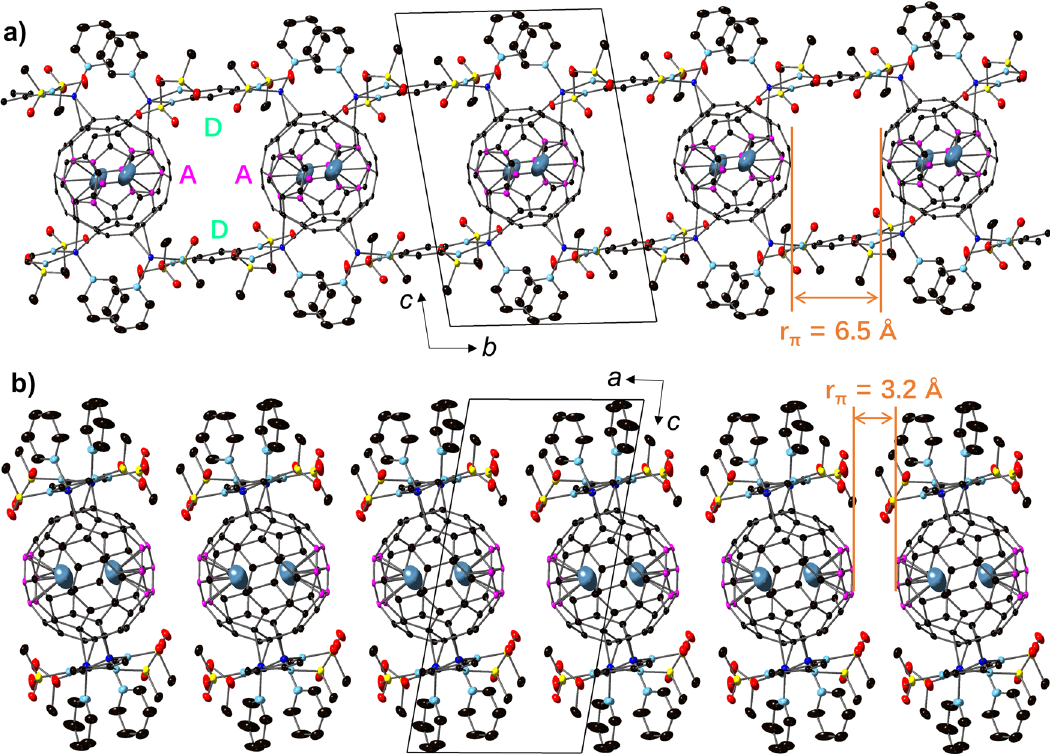
Fig. 2 The structure arrangements of the ladder-like chains. a 1D ladder-like structure along the b -axis in the bc plane (anion NTf 2 − and hexane molecules are omitted). One Li + @C 60 cage coordinates with four Cu ions and the remaining four-terminal Cu ions coordinate with the adjacent Li + @C 60 cage to form a 1D ladder-like structure. Distance r π between adjacent Li + @C 60 cages is 6.5 Å . The Li atoms are off-centred and polarised above/below the Cu plane. b Top view of the 1D ladder-like structure in the ac plane. Each structure stacks along the a -axis to form a 2D interacting sheet with intermolecular distance = 3.2 Å between two Li + @C 60 cages. Colour code: Cu (blue), sulphur (yellow), oxygen (red), nitrogen (pastel cyan), carbon (black/pink). Hydrogen atoms are omitted for